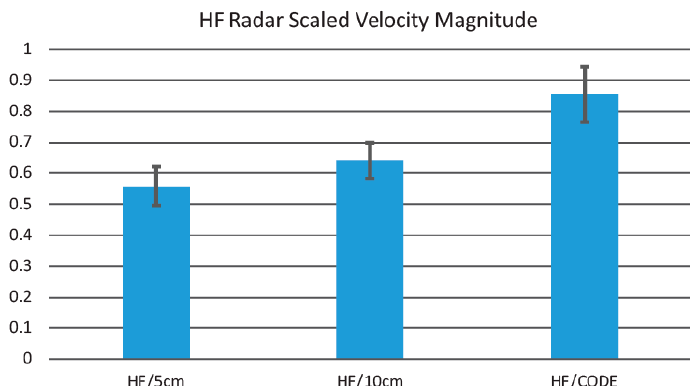
Figure 8. Mean magnitude of the HF radar velocity relative to binned 5-cm, 10-cm, and CODE-style drifter velocity as calculated by Equation (1). Error bars represent the 95% confidence interval of the estimate of the mean.